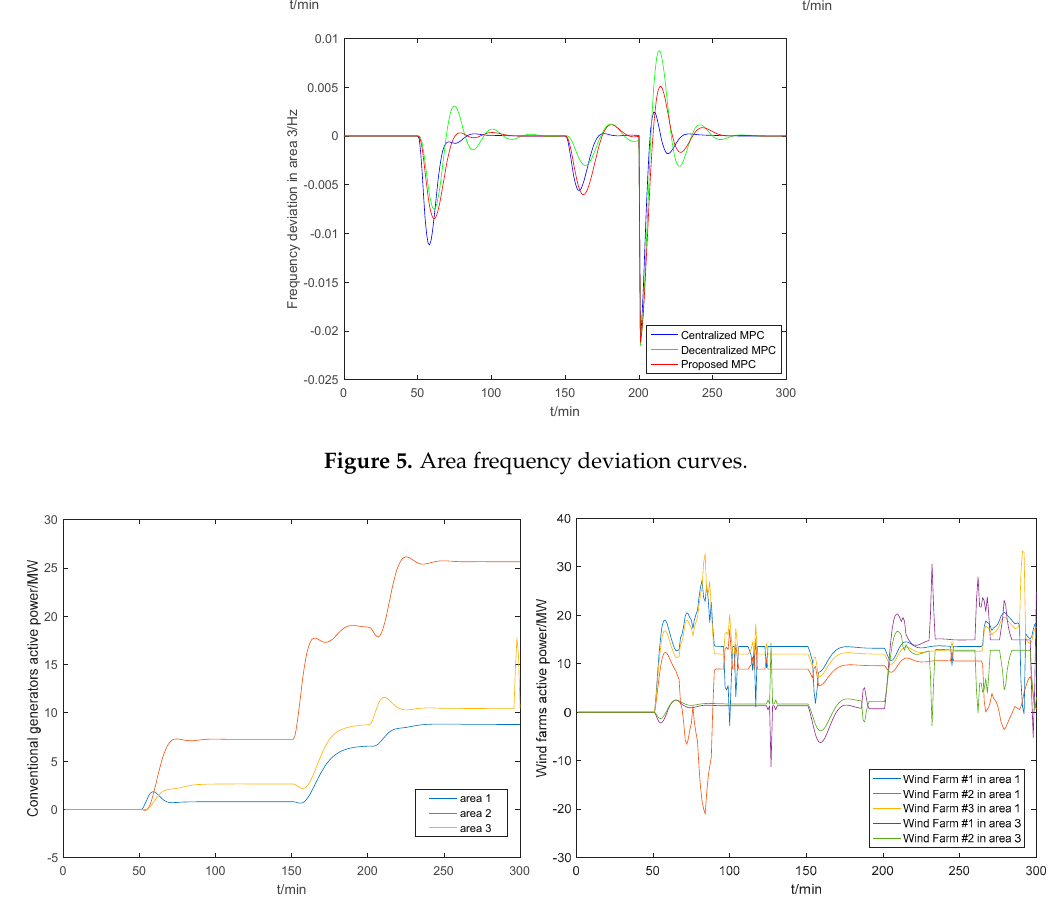
Figure 6. Active power control curves.